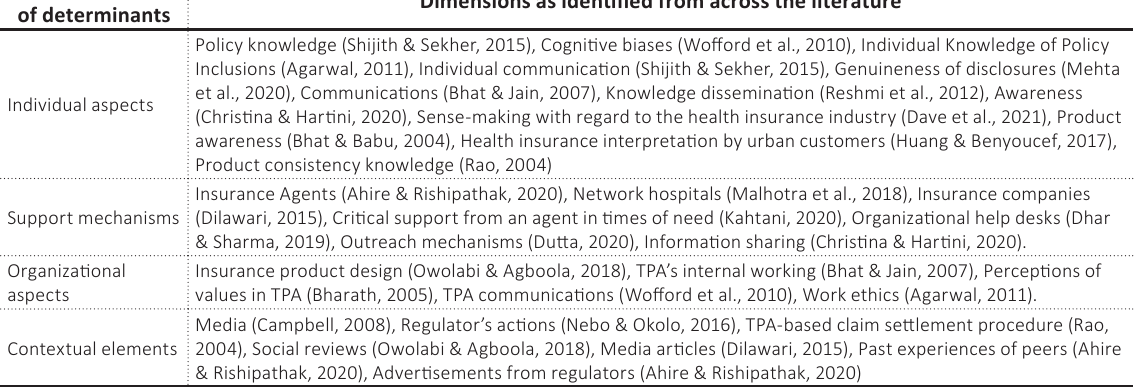
Source: Authors’ elaboration.